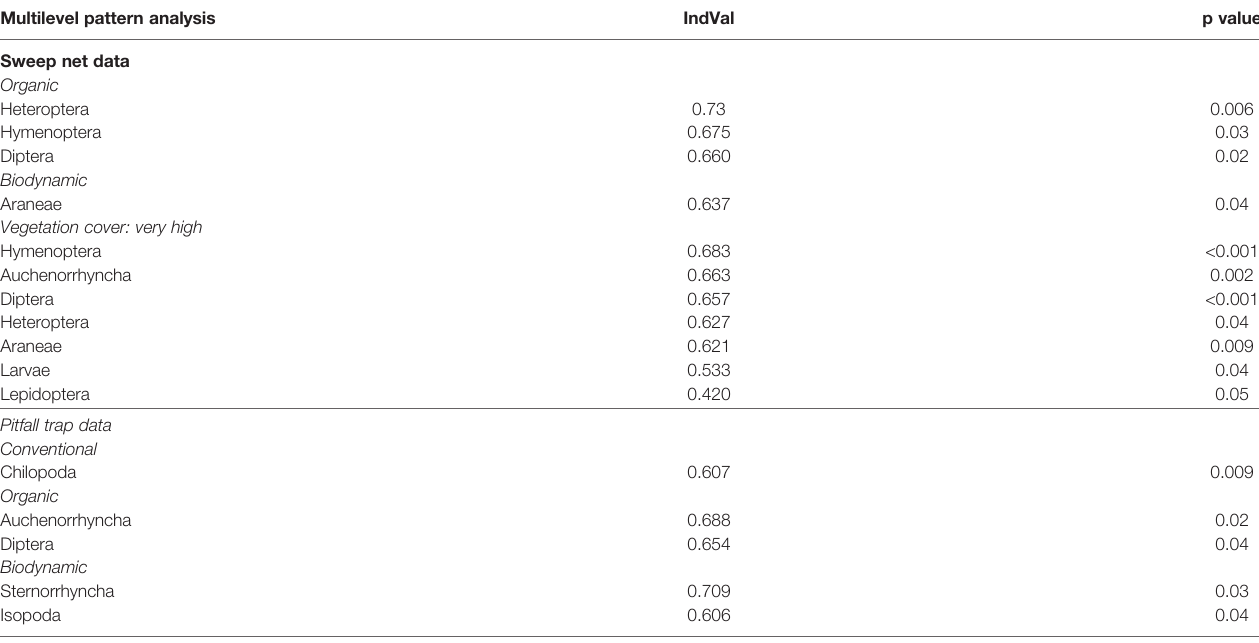
TABLE 2 | Indicator analyses output, showing only signi fi cant links given by indicator values (IndVal) ranging from >0.5 to 1. Multilevel pattern